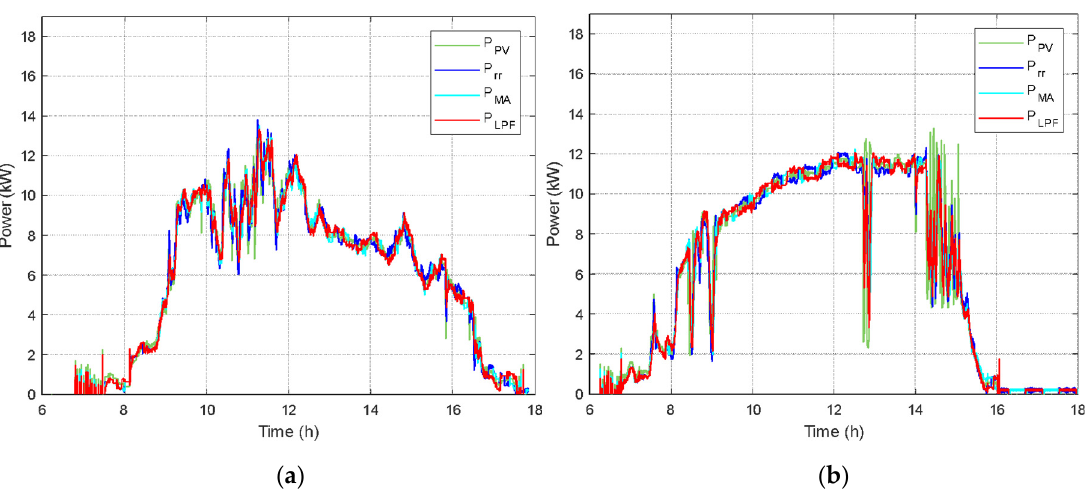
Figure 11. Photovoltaic power and injected power applying the three strategies under study: ( a ) the intermediate fluctuation day (23 November 2018) and ( b ) the day with less fluctuation irradiance (24 November 2018).